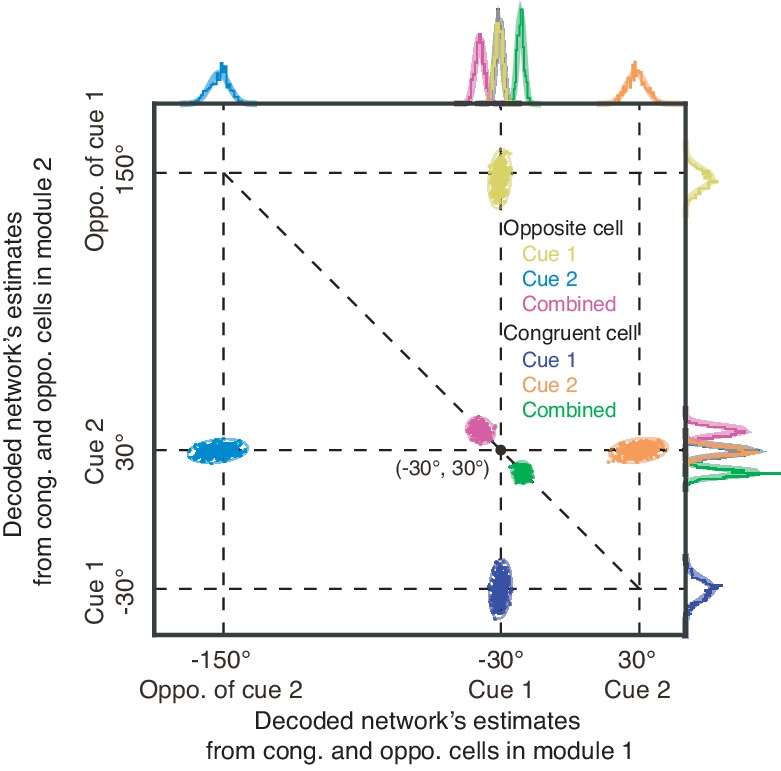
Illustration of decoded joint distributions from congruent and opposite neurons.Illustration of decoded joint distributions from congruent and opposite neurons respectively in two network modules under three cueing conditions, with the marginal distributions plotted in the margin plot. The joint distribution from congruent neurons in two network modules encode the posterior p⁢(s1,s2|x1,x2), while the one from opposite neurons in two modules represent the cue disparity information pd⁢(s1,s2|x1,x2). Color denotes the cueing condition and type of neurons (see the legend for details). Parameters are the same as those in Figure 6A–E in main text.